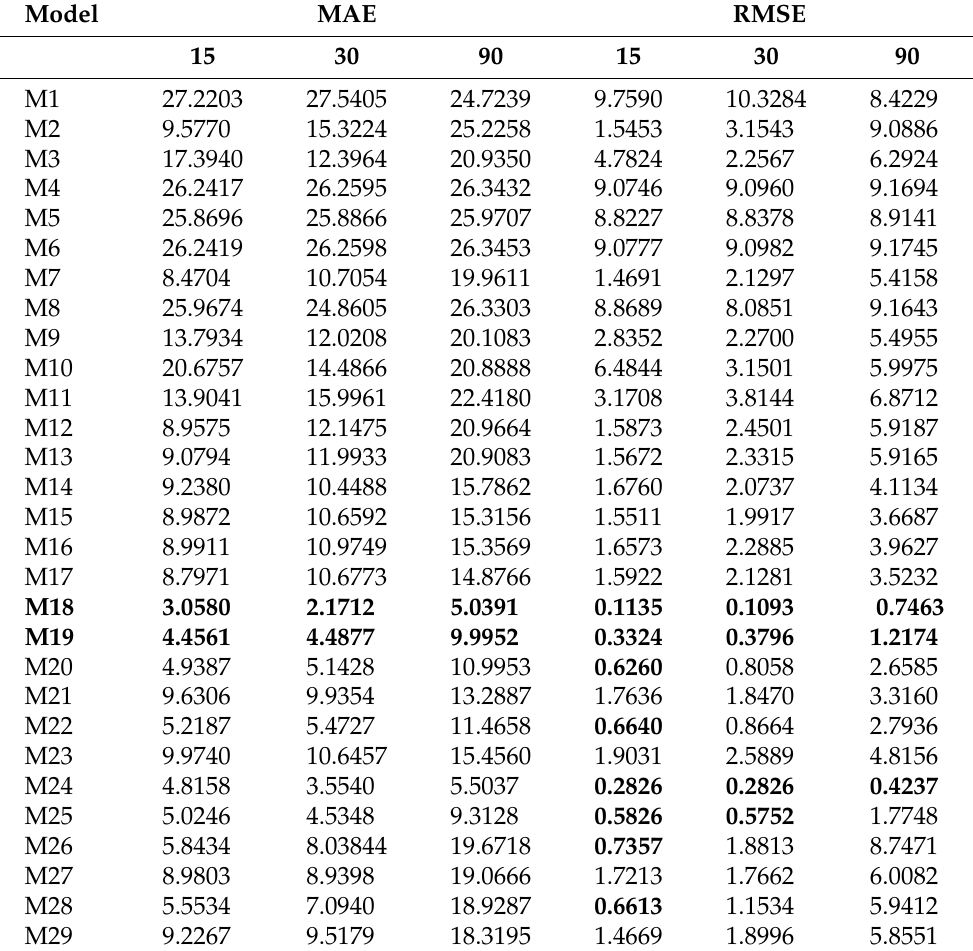
Table 3. Metrics of methods with time